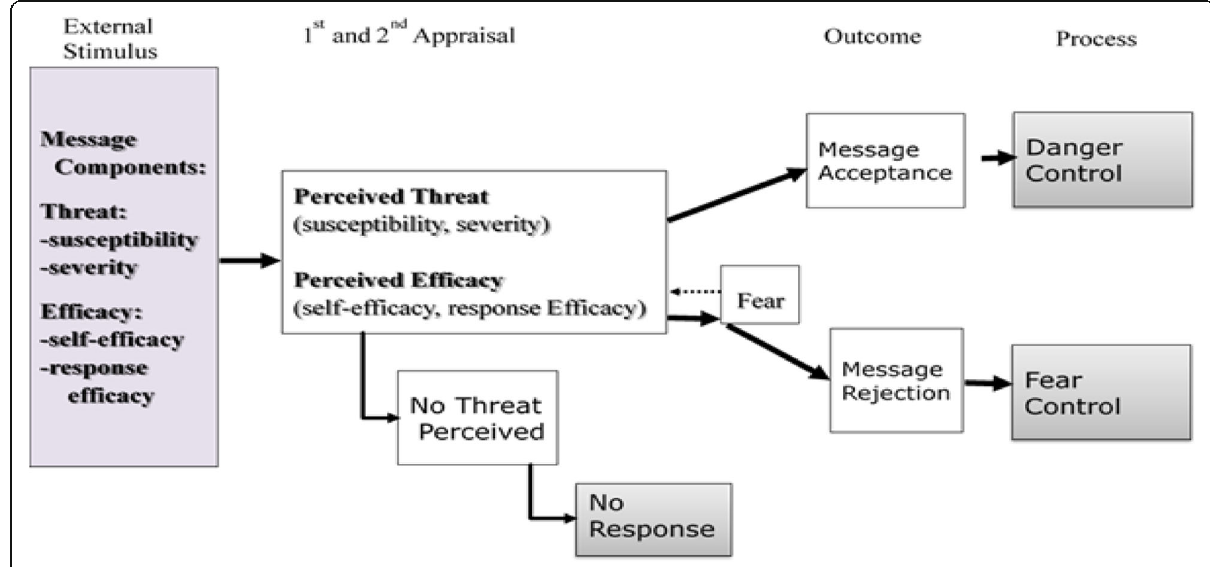
Fig. 1 The extended parallel process model